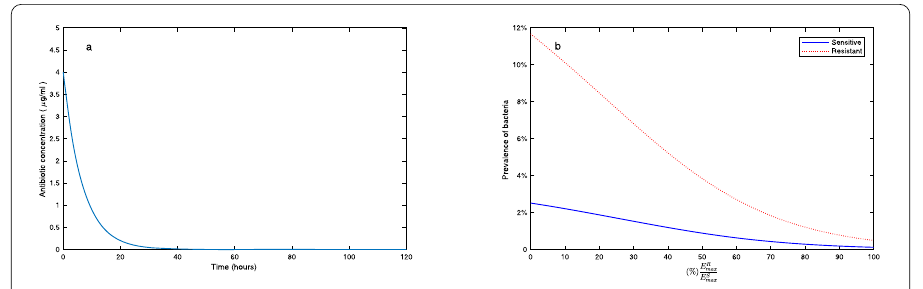
Figure 4 Drugconcentrationandefficacy . ( a ) Antibiotic concentration profile with the initial dose A 0 = 4 μ g/ml, and ( b ) the ratio between the maximum kill rate of resistant bacteria and the maximum kill rate of sensitive bacteria ( S (0) = R (0) = 10 3